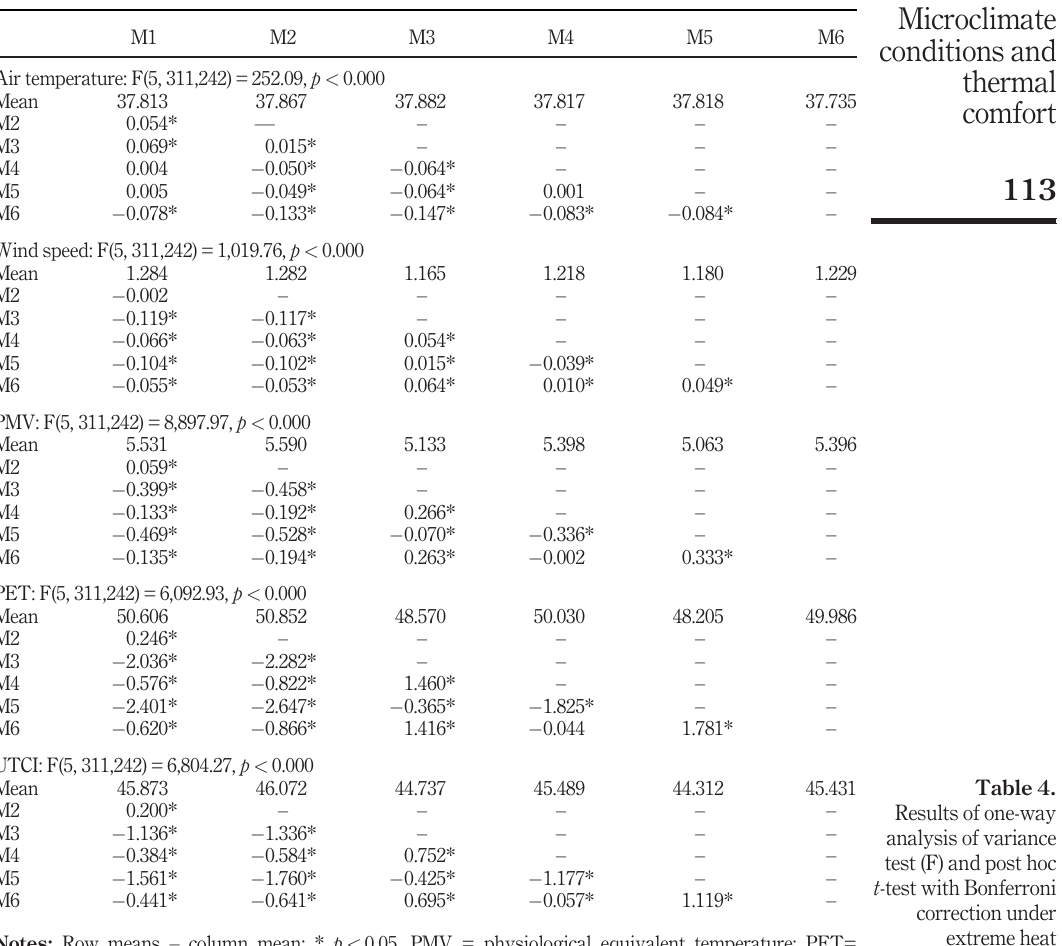
Table 4. Results of one-way analysis of variance test (F) and post hoc t -test with Bonferroni correction under extreme heat